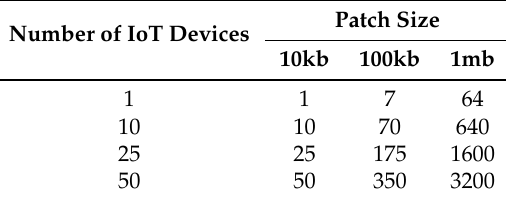
Table 4. Cost measure (millisatoshi).